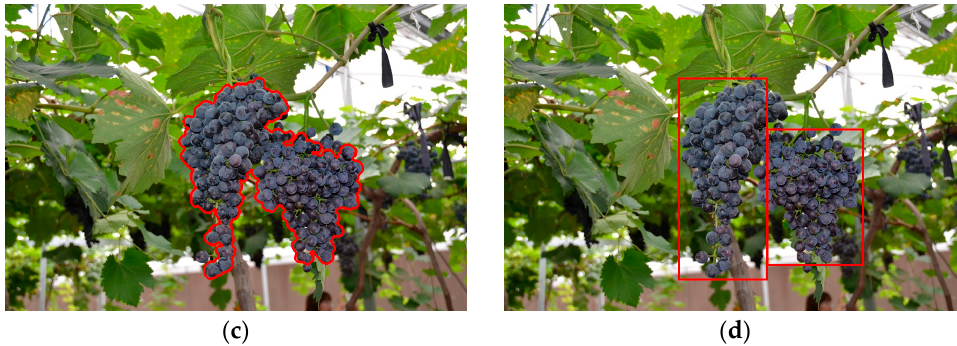
Figure 6. The detection processes of grape clusters in Figure 3a. ( a ) Obtained binary image by using the strong classifier; ( b ) Obtained grape region image after eliminating noises and executing a morphological operation (blue point was the barycenter); ( c ) The contour of the detected grape clusters; and ( d ) The enclosing rectangle were drew in the original image.